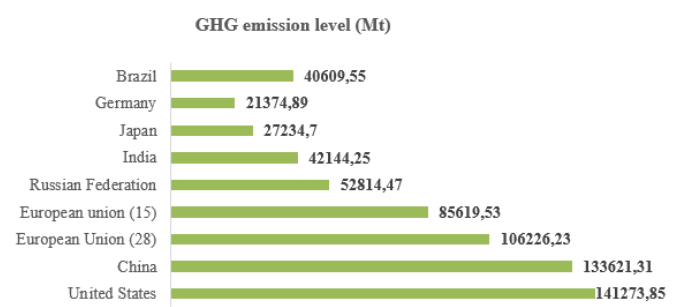
Figure 1. Emissions of GHG by the most GHG emitting countries in 1990-2012.